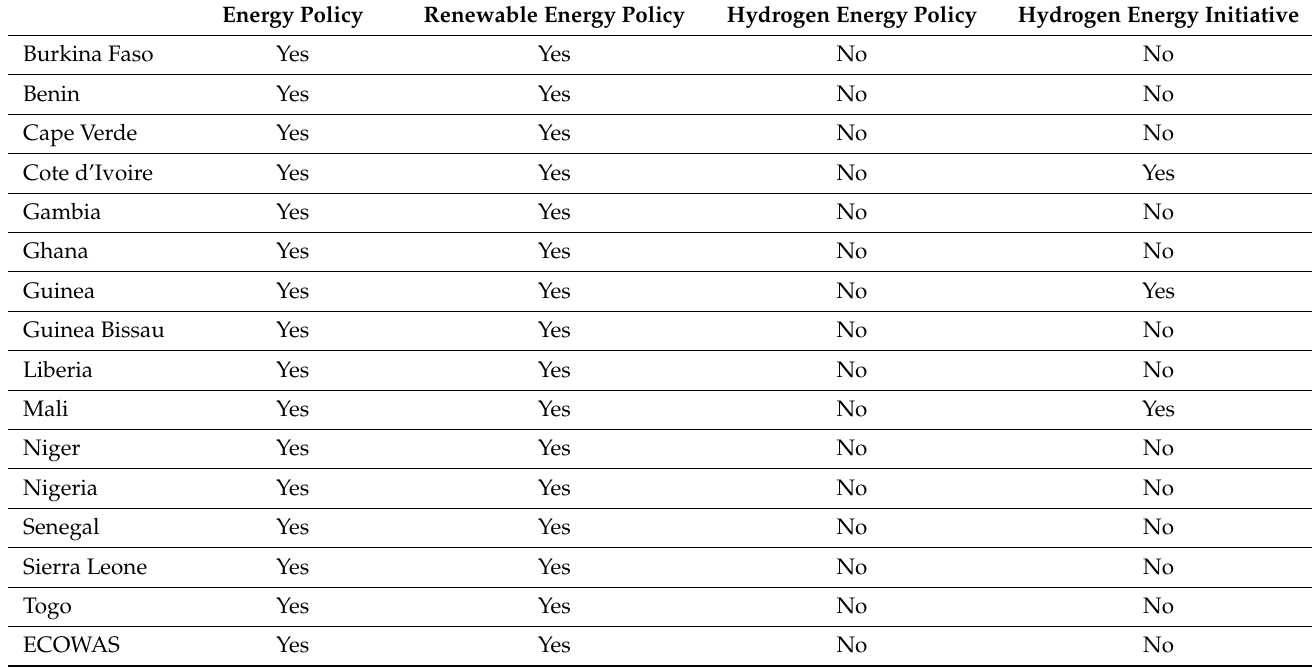
Table 2. ECOWAS Energy Policy